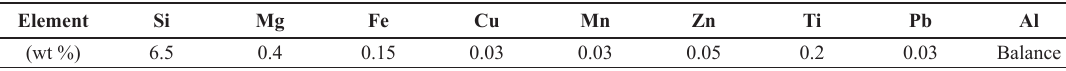
Table 1. The chemical composition of A356 alloy used in experimental